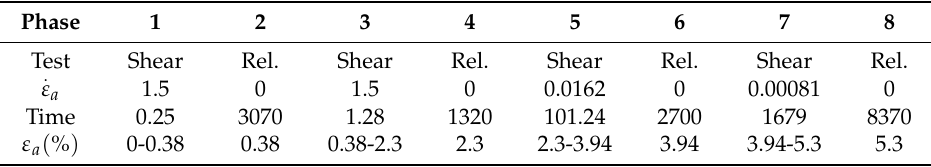
Table 4. Stress relaxation test on the SFBM